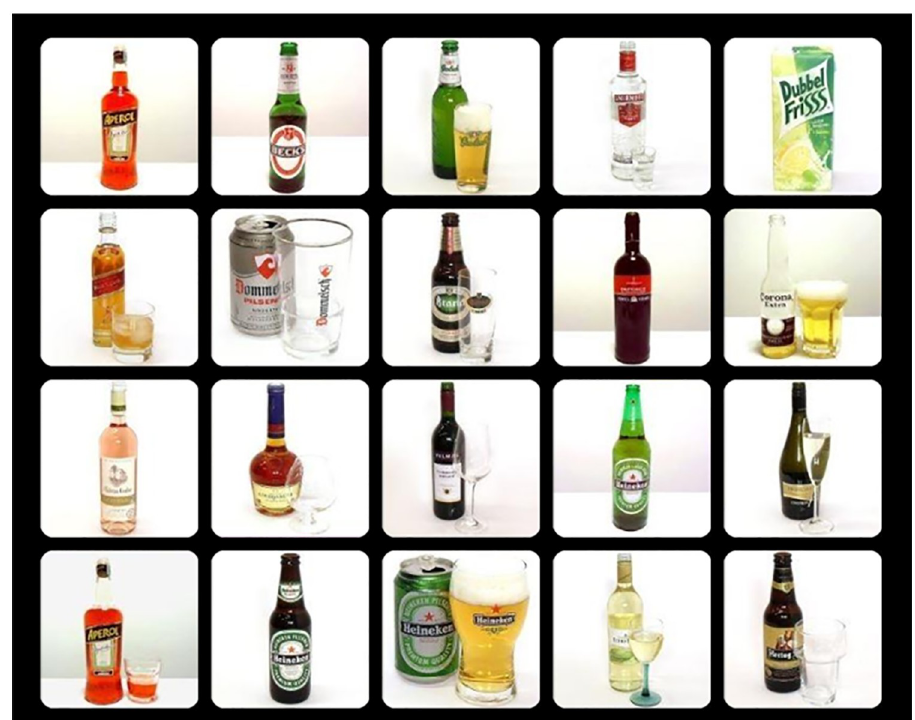
Fig 2. Example of an alcohol distractors trial of the